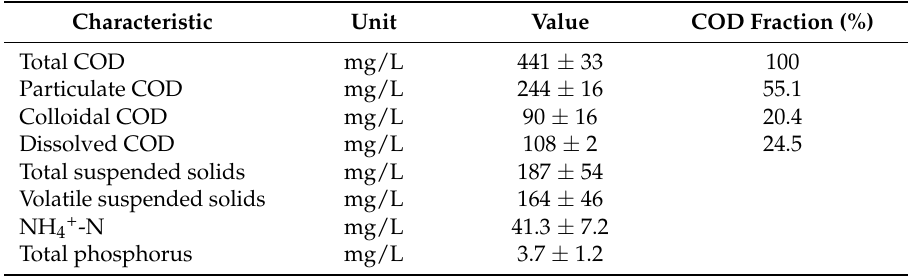
Table 1. Summary of influent wastewater characteristics over the sampling period. COD indicates chemical oxygen